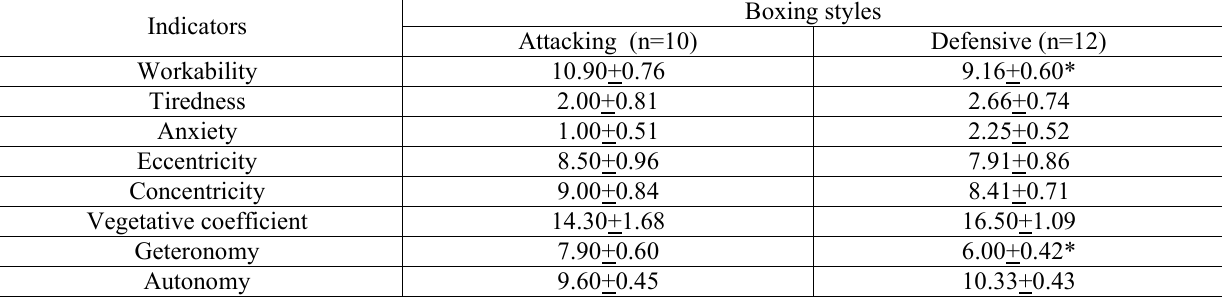
Mean values of digital Lucher test’s indicators of different styles’ boxers (n=22)